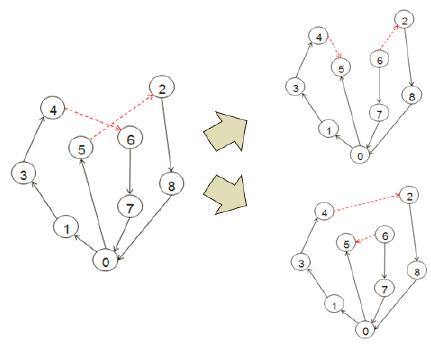
Figure 7. The 2-opt swap method concept.